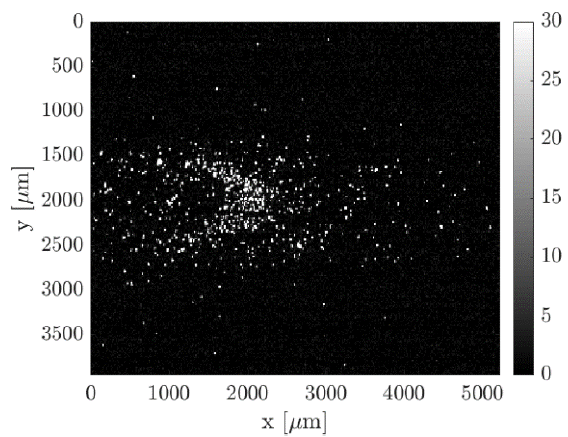
Figure 6. Example of a raw image acquisition of the acetone emission in argon flow at 𝑝 𝑚 = 30 kPa, Δ𝑝 = 550 Pa, and an acetone molar concentration 𝜒 = 20%. The image results from the integration of 𝑁 𝑙 = 100 laser excitations, with delay Δ𝑡 = 50 µs, gain 𝐺 = 100%, IRO gate Δ𝑡 𝑔𝑎𝑡𝑒 = 100 ns, and 4 × 4 binning.